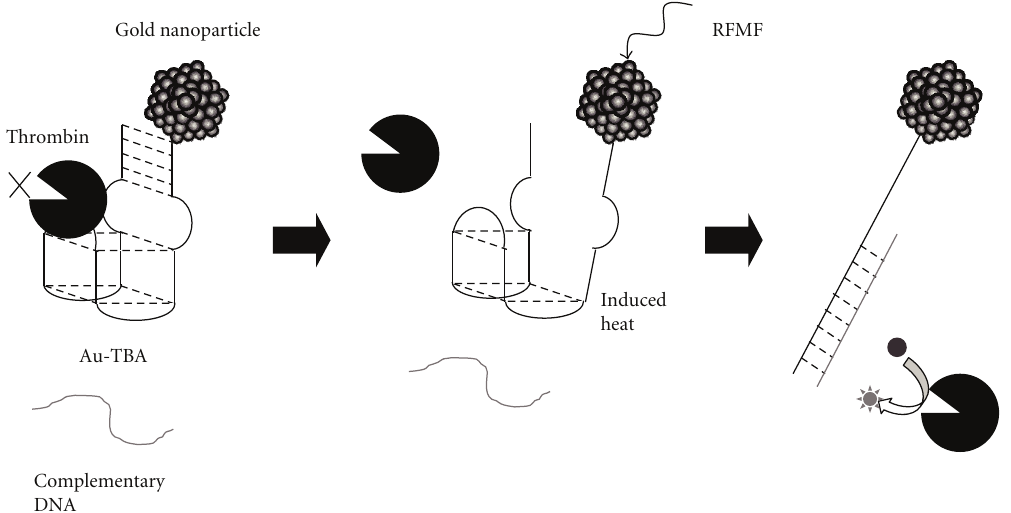
Figure 1: The scheme for the controlling of the function of gold nanoparticle-conjugated thrombin-inhibiting aptamer by